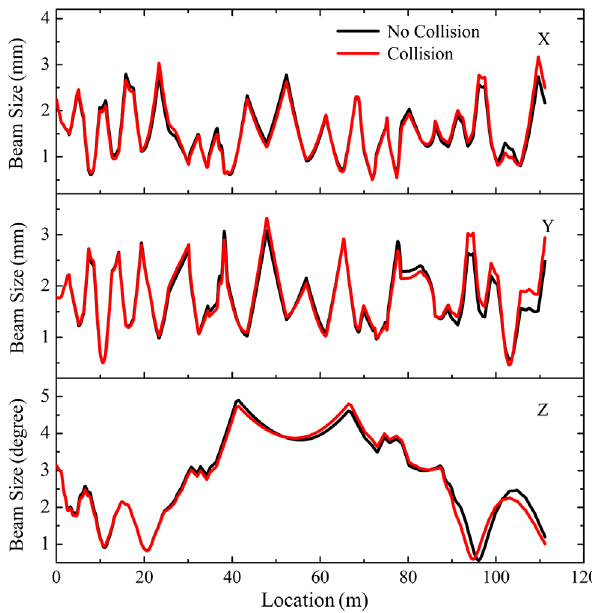
FIG. 7. The rms emittance and 95% percent emittance evolu- tion of the single-bunch simulation and the simulation including multiple collisions through the double-pass linac.